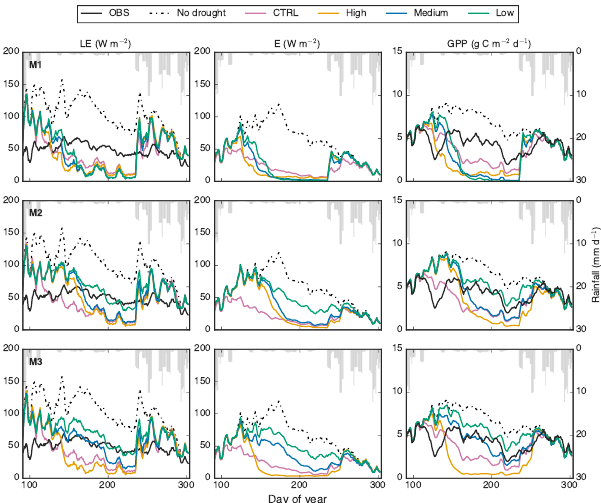
Figure 7. A comparison of the observed (OBS) and modelled la- tent Heat (LE), transpiration ( E ) and gross primary productivity (GPP) at the Espirra site during 2003. Simulations show the con- trol (CTRL) and the three parameterisations that represent a spec- trum of behaviour ranging from a high to low drought sensitivity, and the tested methods to obtain a weighted estimate of soil water potential ( (cid:57) S ) across CABLE’s soil layers (M1–M3). M1 uses a root-biomass weighted soil water content converted to (cid:57) S , M2 cal- culates (cid:57) S by integrated soil water content over the top 1.7m of the soil, and M3 is calculated using a dynamic weight across soil layers. The data have been smoothed with a 5-day moving window to aid visualisation and the grey bars show daily